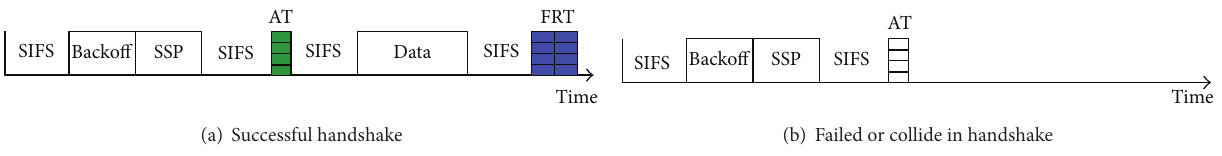
Figure 7: Handshake mechanism in our